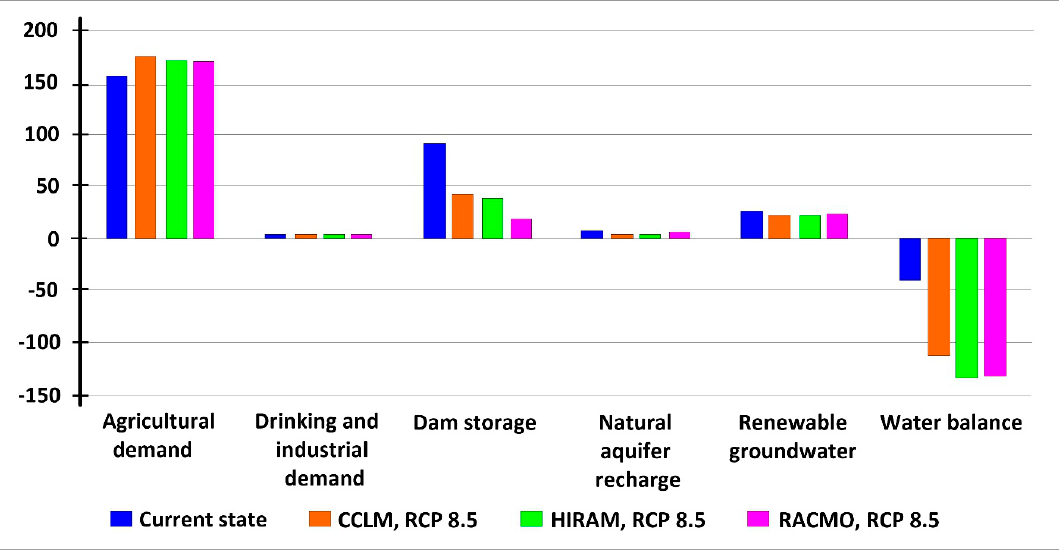
Figure 12. Effects of climate change on water resources in the Souss-Massa basin during 2030–2050 (MCM) [69].